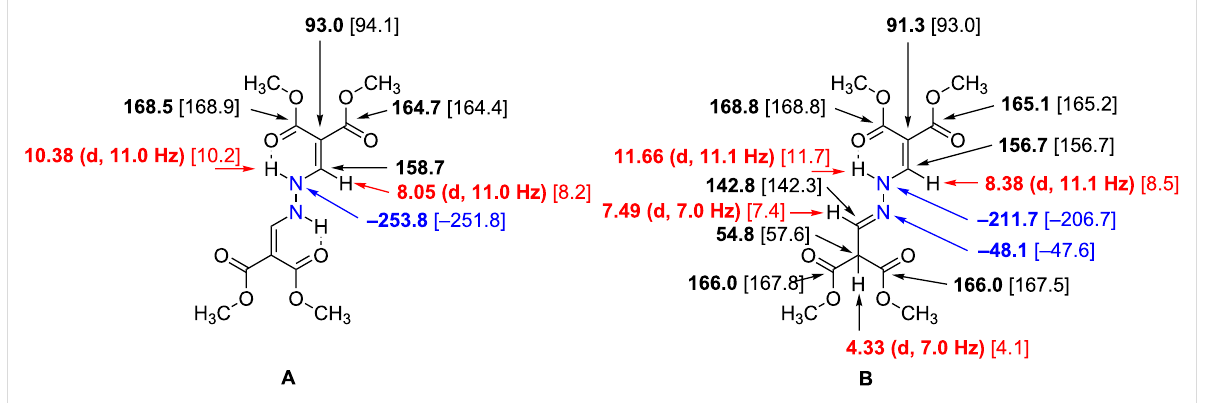
Figure 6: Key 1 H (red), 13 C (black) and 15 N (blue) NMR chemical shifts ( δ , ppm) in isomers A and B of compound 6a . [DFT data are in square brackets.]